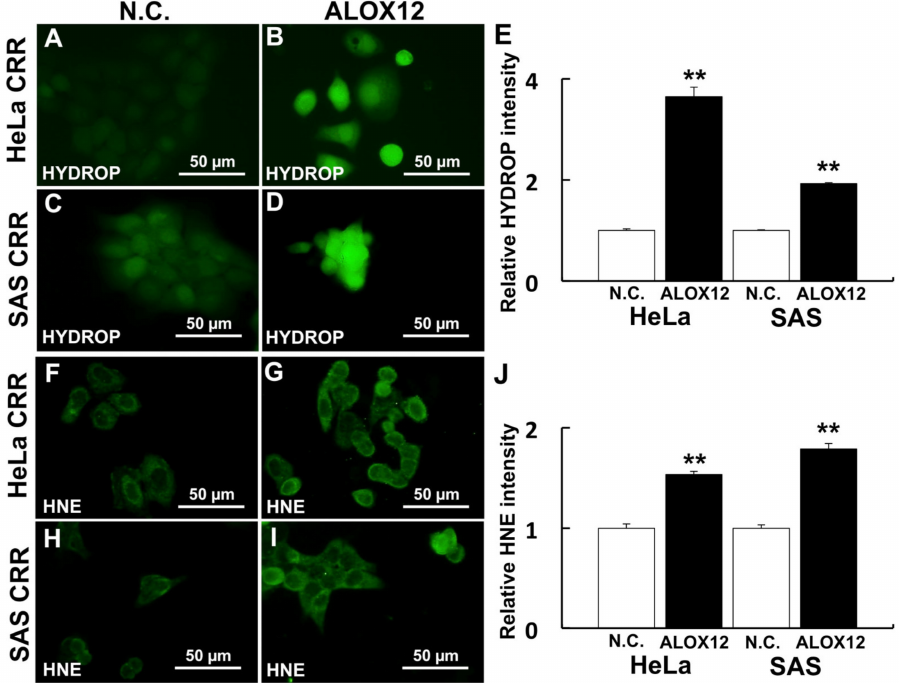
Figure 6. ALOX12 enhances intracellular ROS and lipid peroxidation. Cells were treated with 2.5 µ